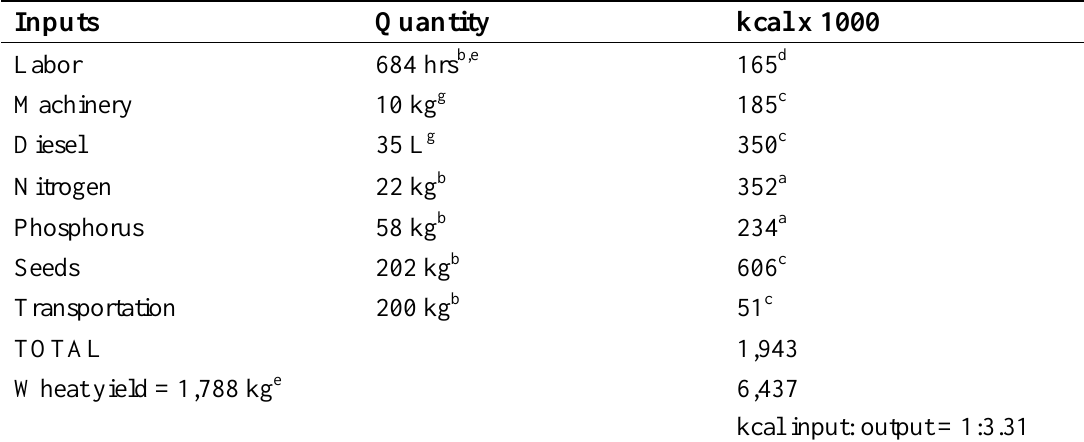
Table 6. Energy inputs of wheat production per hectare in